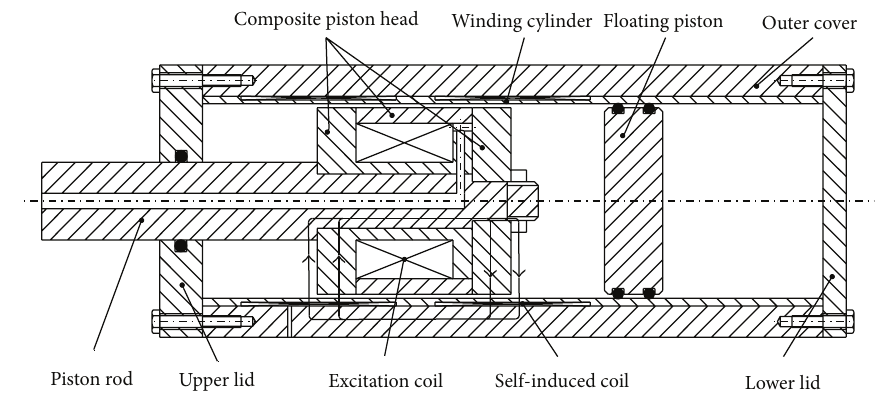
Figure 1: Schematic diagram of the proposed DDSMRD.